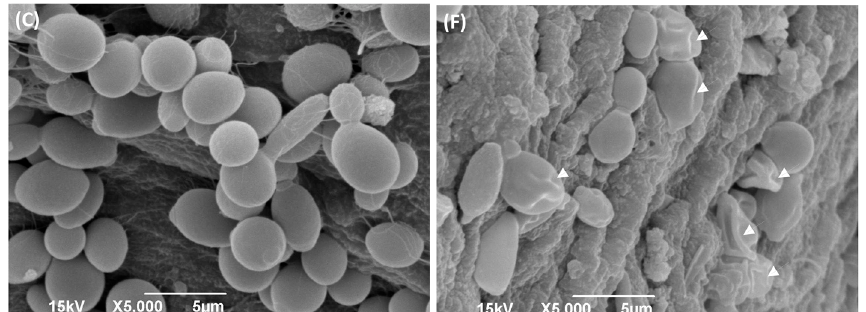
Figure 5. Scanning electron micrograph of C. albicans cells with and without treatment with Capsaicin (MIC). Attachments of Candida cells (Endo ‐ 902 ( A ), Endo ‐ 903 ( B ), and Endo ‐ 904 ( C )) with teeth pulp in without treatment condition are shown in left panel, whereas with treatment condition (Endo ‐ 902 ( D ), Endo ‐ 903 ( E ) and Endo ‐ 904 ( F )) are shown in right panel.